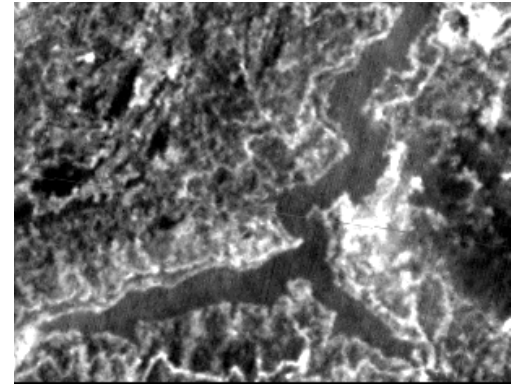
Figure3. Cbers3 image of Guojiaba Town in Three